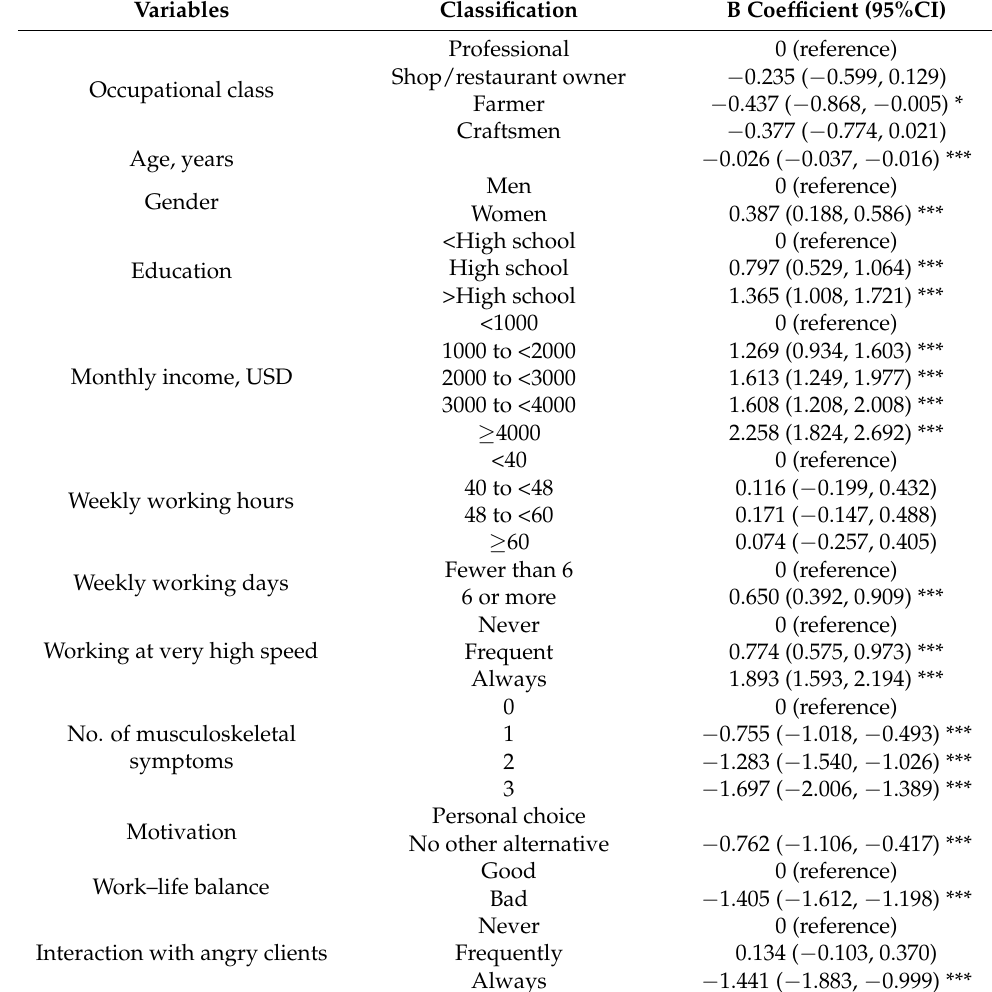
Table 3. Multivariate linear regression analysis of the association of psychological well-being score with occupational class, demographic factors, socioeconomic factors, and psychosocial work-related factors in the self-employed workers ( n =